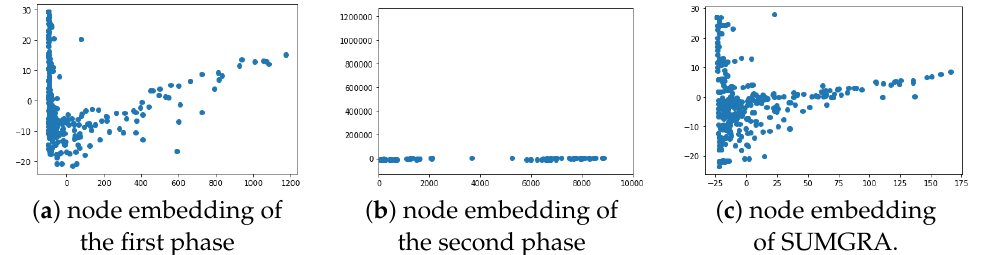
Figure 17. Node embedding of EUAi dataset: ( a ) node embedding of the first phase of the proposed, ( b ) node embedding of the second phase of the proposed with/without meta-features, and ( c ) node embedding of the SUMGRA.